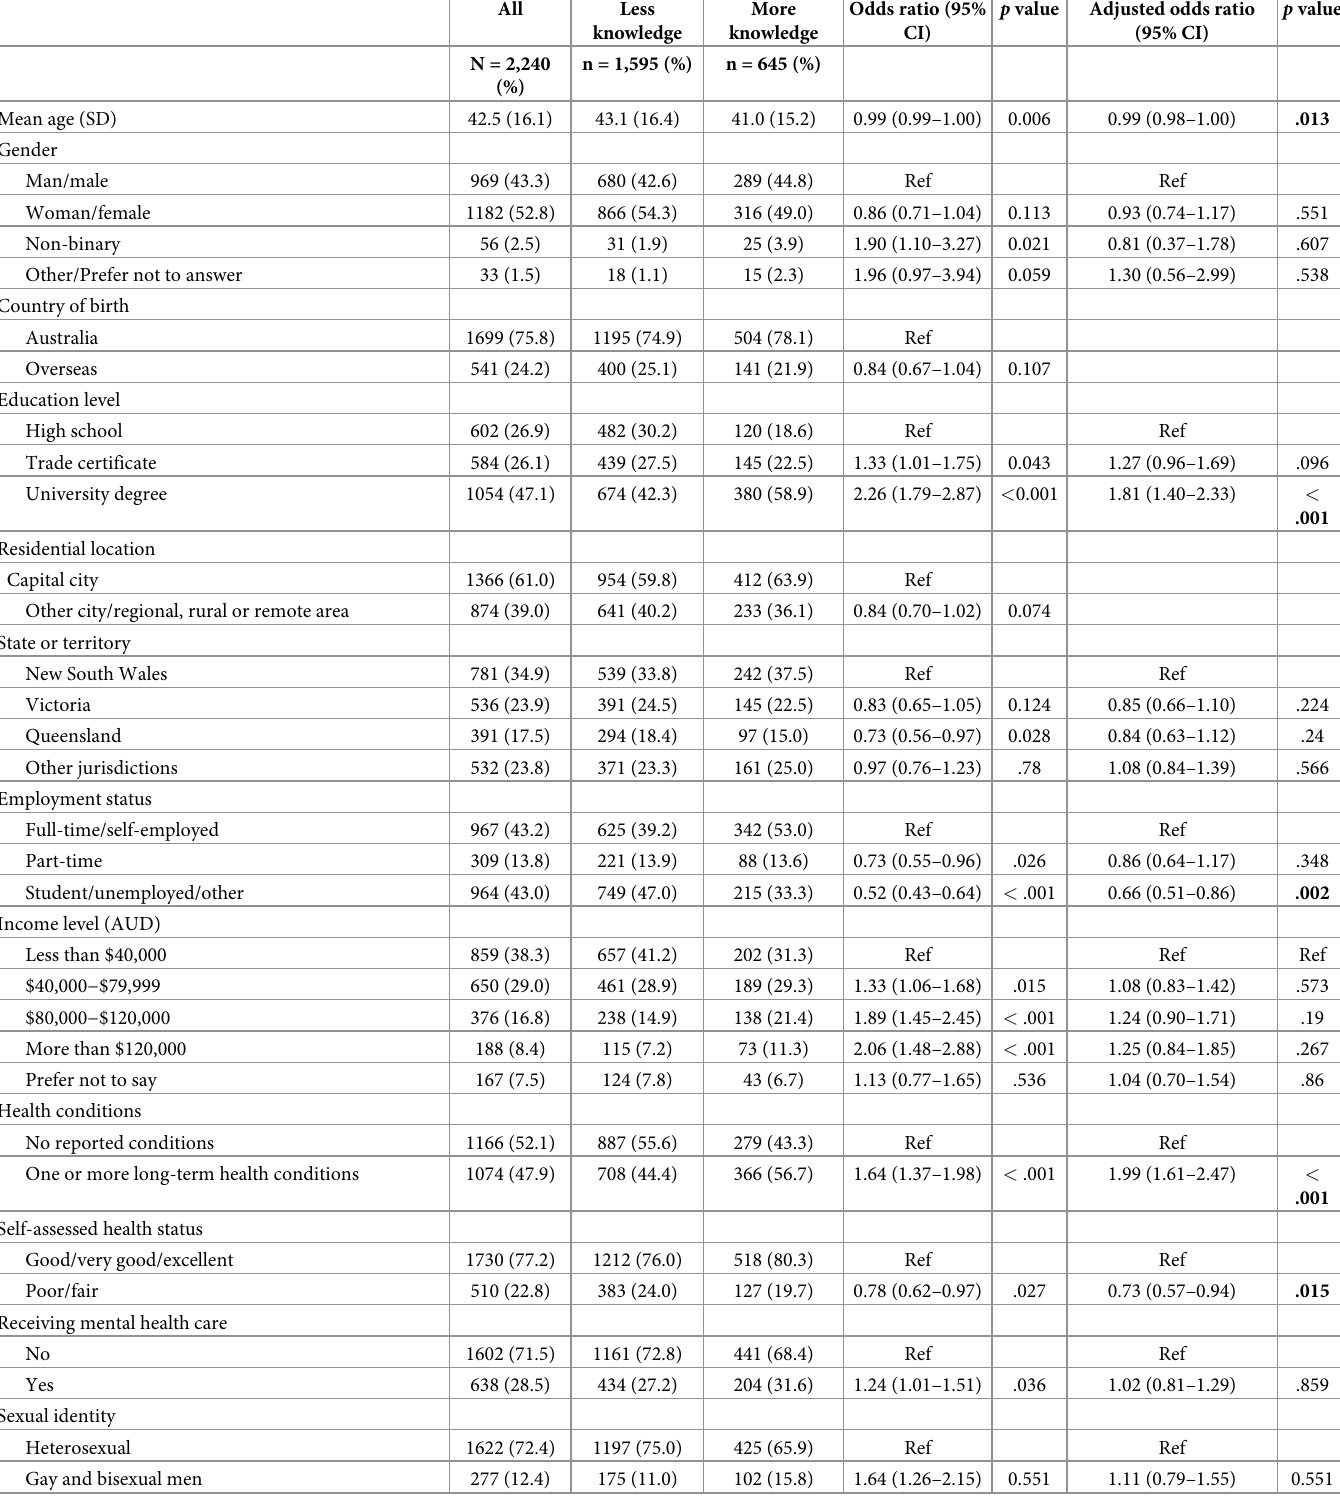
Table 1. Participant characteristics and factors associated with greater knowledge about My Health Record (N =